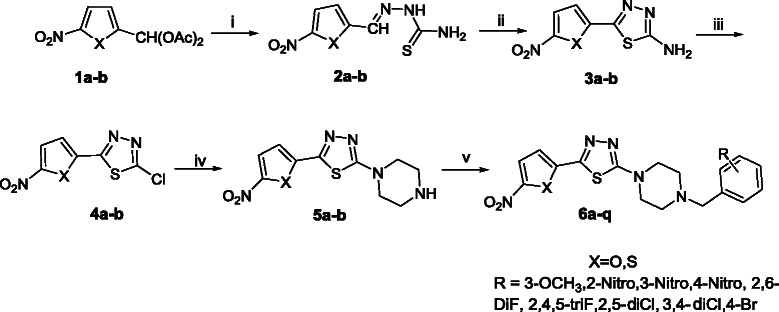
Reagents and conditions: (i) thiosemicarbazide, EtOH, HCl, reflux, 1.5 h; (ii) NH4Fe(SO4)2, 12H2O, H2O reflux, 25 h; (iii) NaNO2, HCl, Cu, °C→ rt, 3 h; (iv) Piperazine hydrate, EtOH, NaHCO3 1 h; (v) DMF, Substituted benzyl chloride, 4 h.